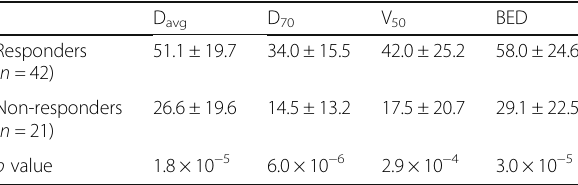
Table 3 The mean dose (Gy ± stdev) corresponding to responding and non-responding lesions for each of the investigated metrics, including the p value from the two-sided t test of significance (set at